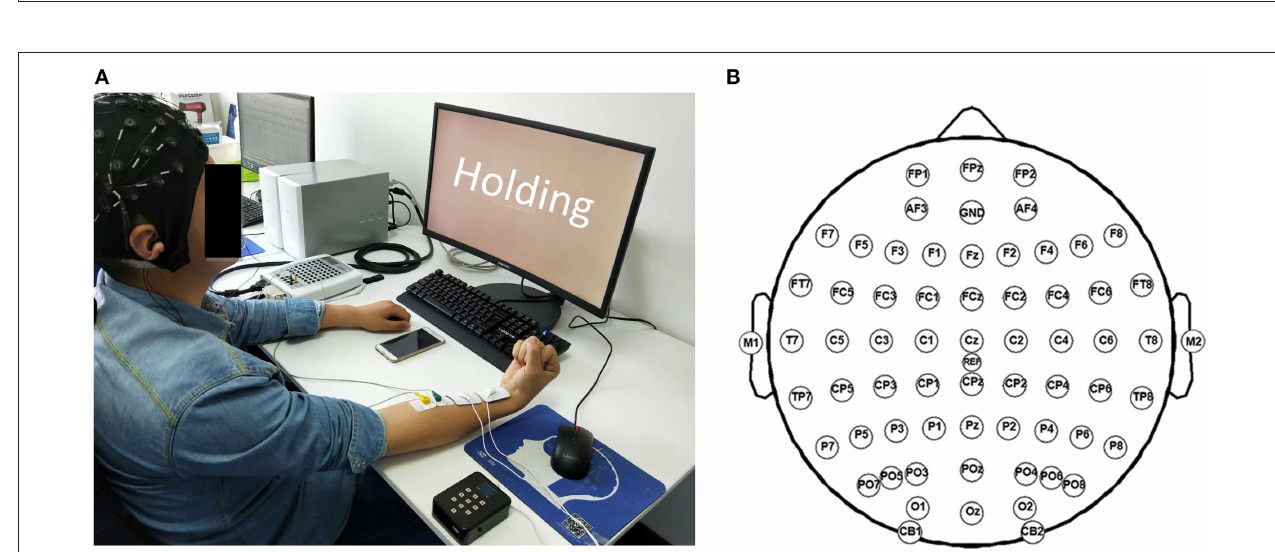
FIGURE 2 | Experiment scene. (A) The photo of one participant during the experiment. ( B ) Channel locations according to the international 10–20 system.